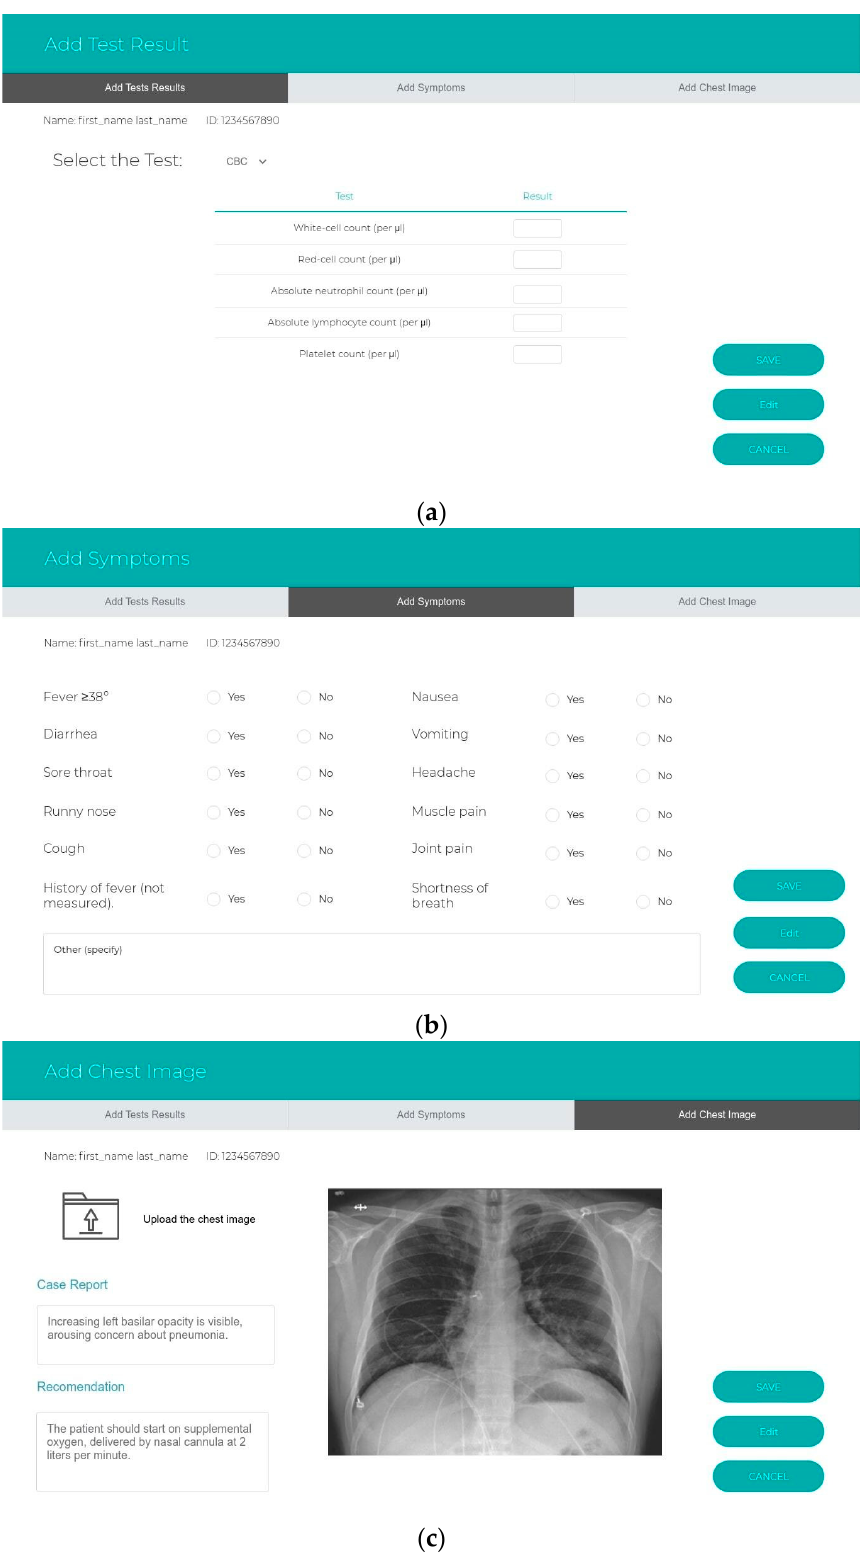
Figure 3. The prototype interfaces for the sub-system. The information management system: ( a ) add test results, ( b ) symptoms, ( c ) upload chest imaging.